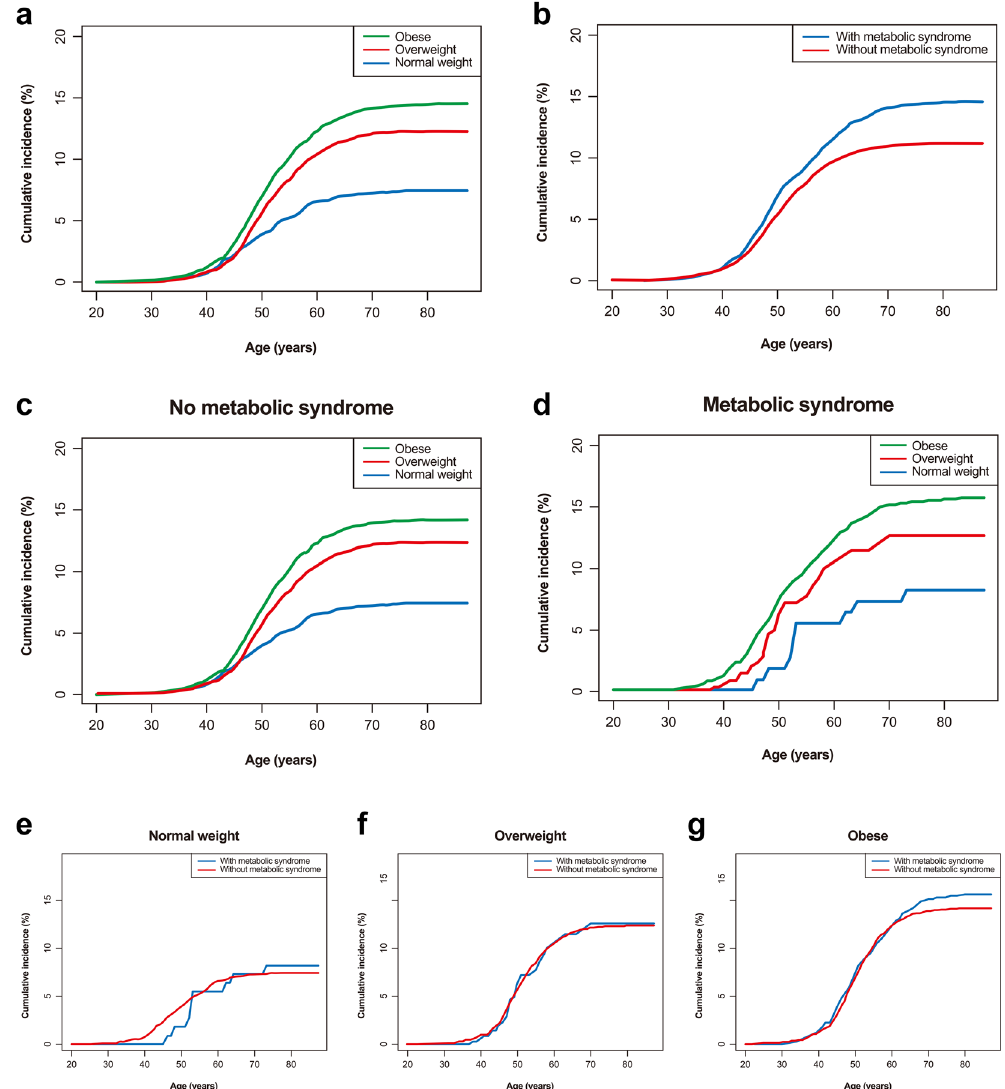
Figure 1. Risk of erosive reflux disease according to body mass index category ( a ) and absence/presence of the metabolic syndrome ( b ). Cumulative incidences of erosive reflux disease according to body mass index category in groups classified by absence ( c )/presence of the metabolic syndrome ( d ). Cumulative incidences of erosive reflux disease according to absence/presence of the metabolic syndrome in groups classified by body mass index category (normal weight: ( e ), overweight: ( f ), obese: ( g